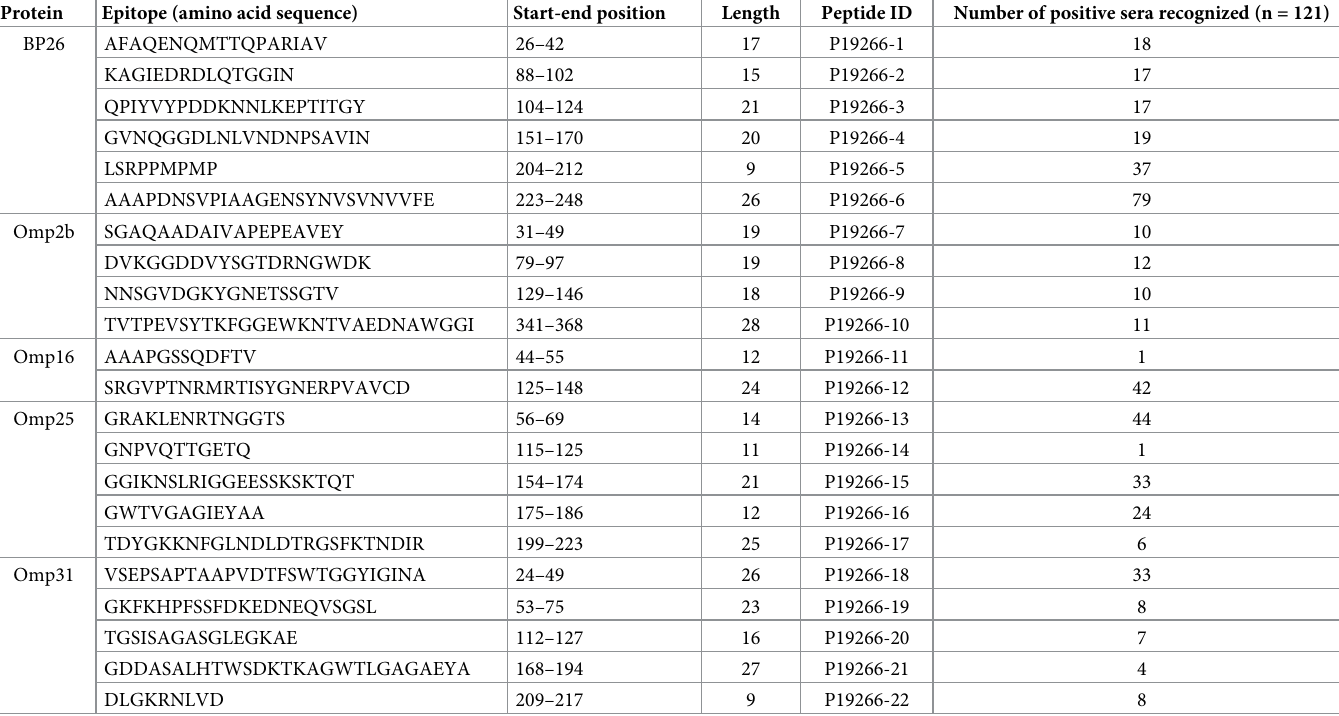
Table 1. Information about 22 predicted B cell epitopes. Protein Epitope (amino acid